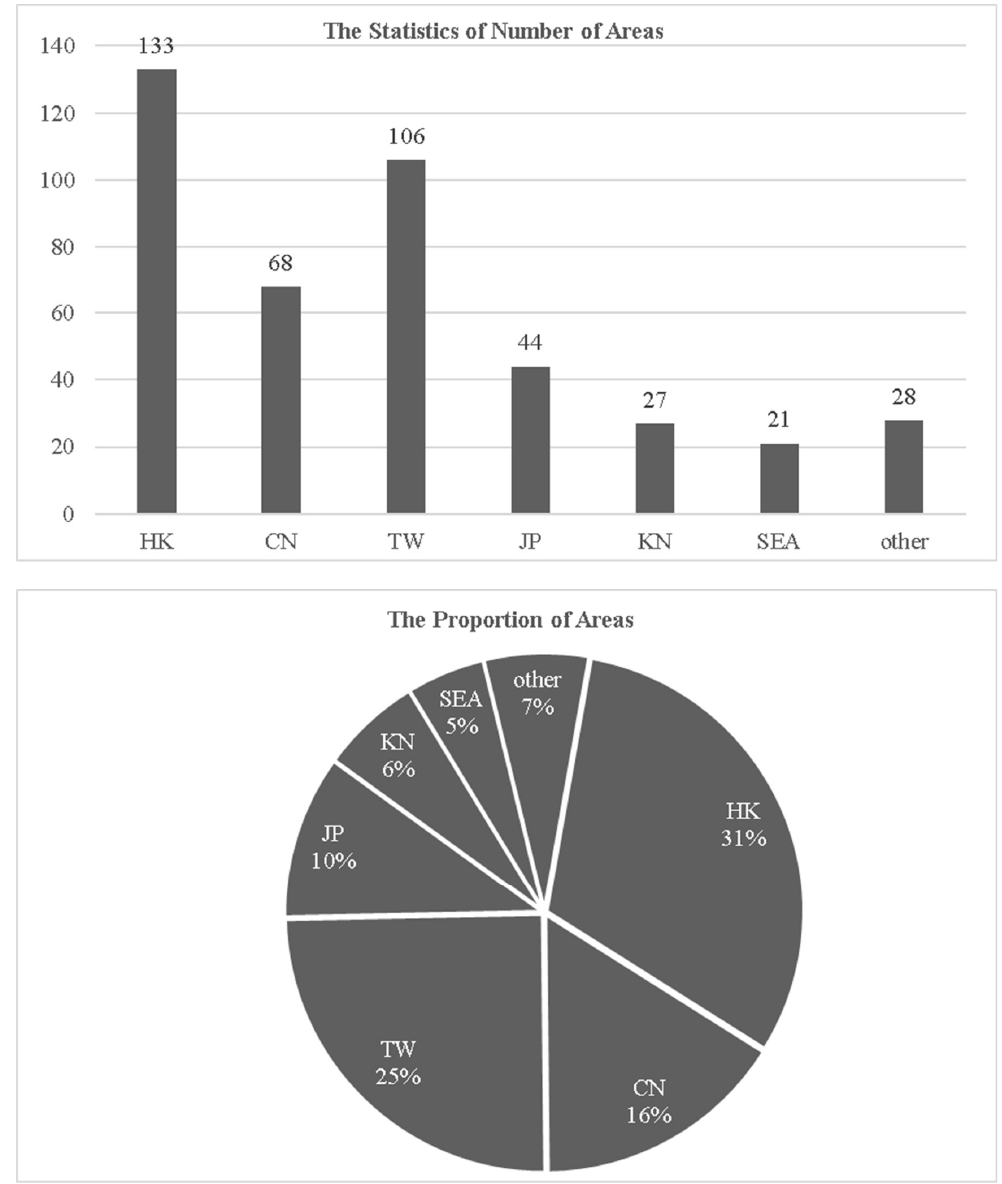
Figure 2. The bar chart and pie chart of the discussed areas of 427 posts.